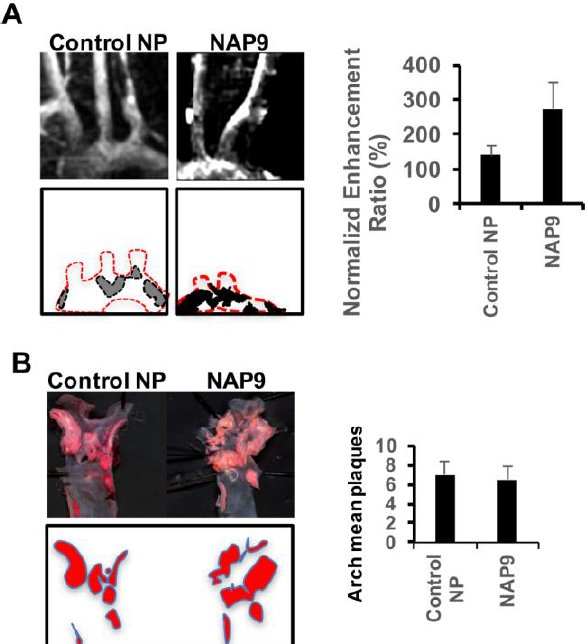
Figure 5. Non-invasive visualization of NAP9 by MRI in the aortic arch of atherosclerotic NOS3/apoE KO mice. ( A ) Images of the aortic arch from NOS3/apoE KO mice injected with 0.1 mg/kg/day control (Control NP, right panel), or NAP9 (left panel). Red dotted lines mark aortic arch and proximal carotid arteries. Black and gray surfaces represent gadolinium enhancement areas corresponding to nanoparticle uptake (Control NP: 139.78 ± 26.288 vs. NAP9: 270.47 ± 73.321; P : 1 × 10 − 4 ). ( B ) OilRedO staining of en face aortic arch from the same mice.